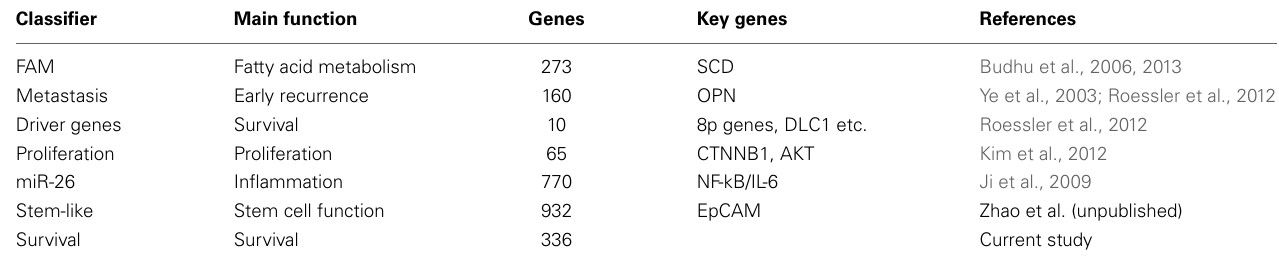
Table 1 | Seven outcome-related HCC gene